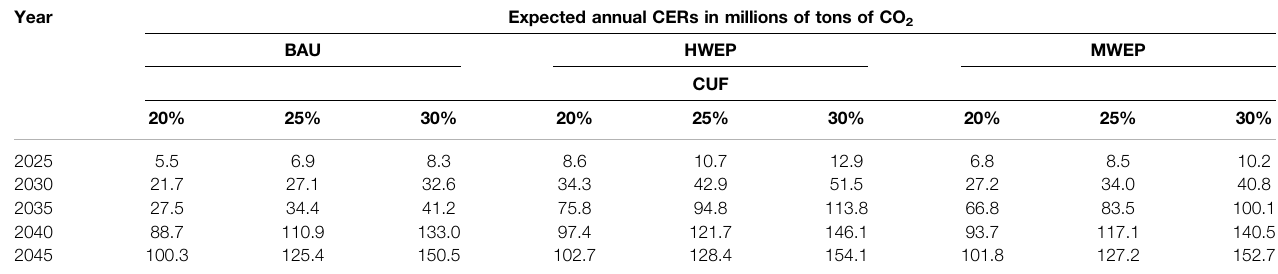
TABLE 6 | Expected annual CERs in different